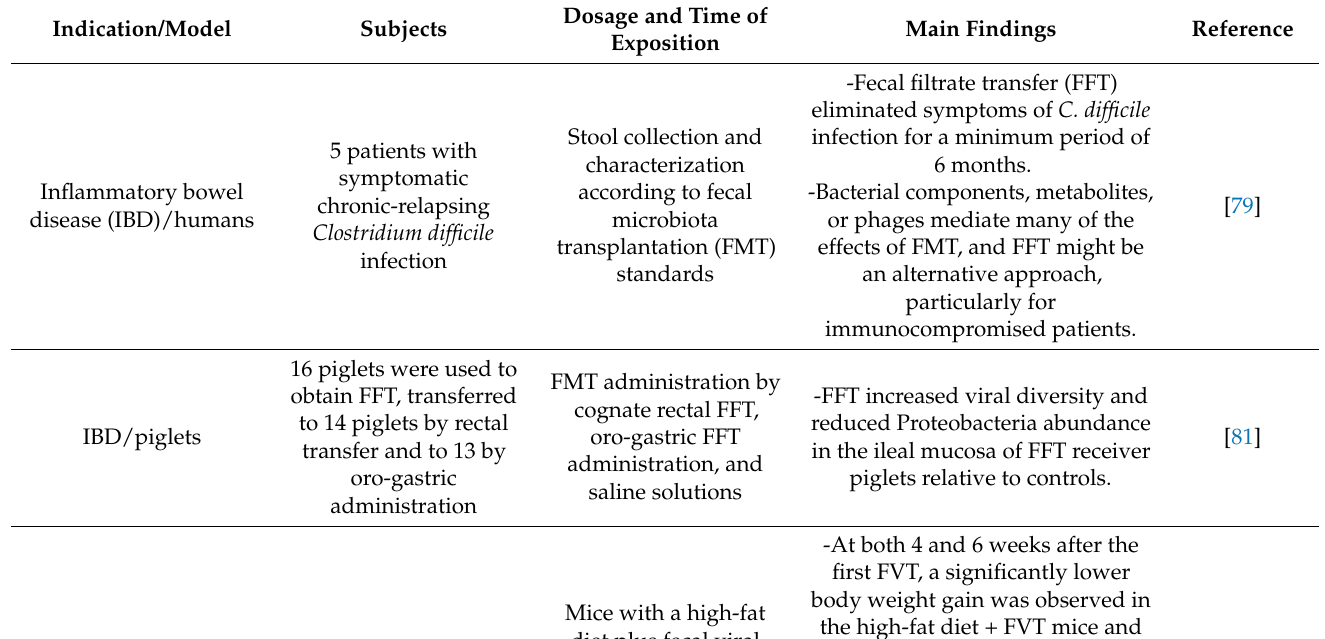
Table 3. Studies investigating fecal viral transplantation and its relationship with specific